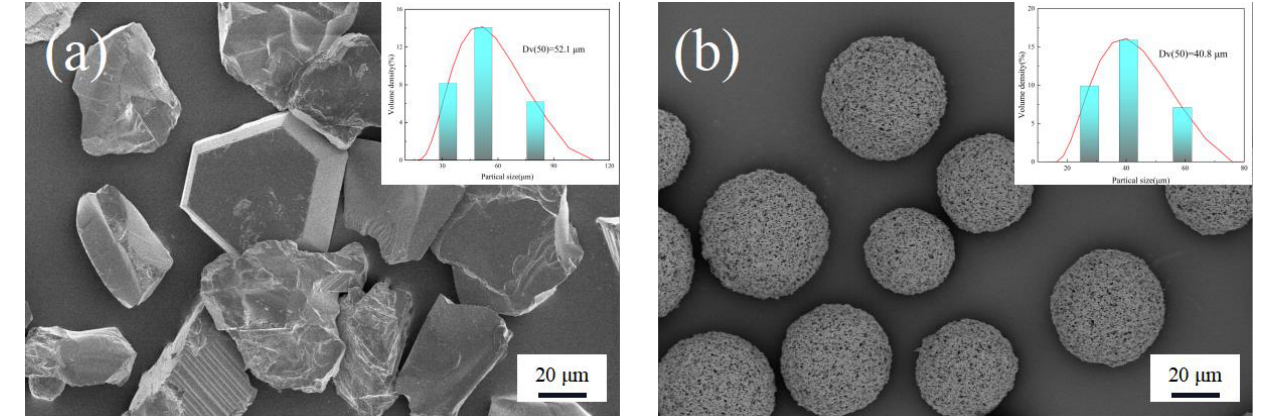
Figure 2. SEM and Laser particle-size analysis of ( a ) conventional micron powder and ( b ) granulated nano-alumina powder generated by atomization.